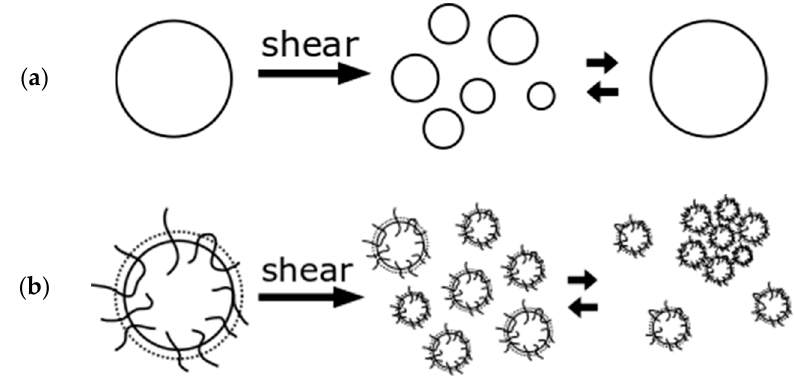
Figure 3. ( a ) Coalescence of dispersed particles without compatibilizer and ( b ) inhibition of coalescence with compatibilizer and possible agglomeration.